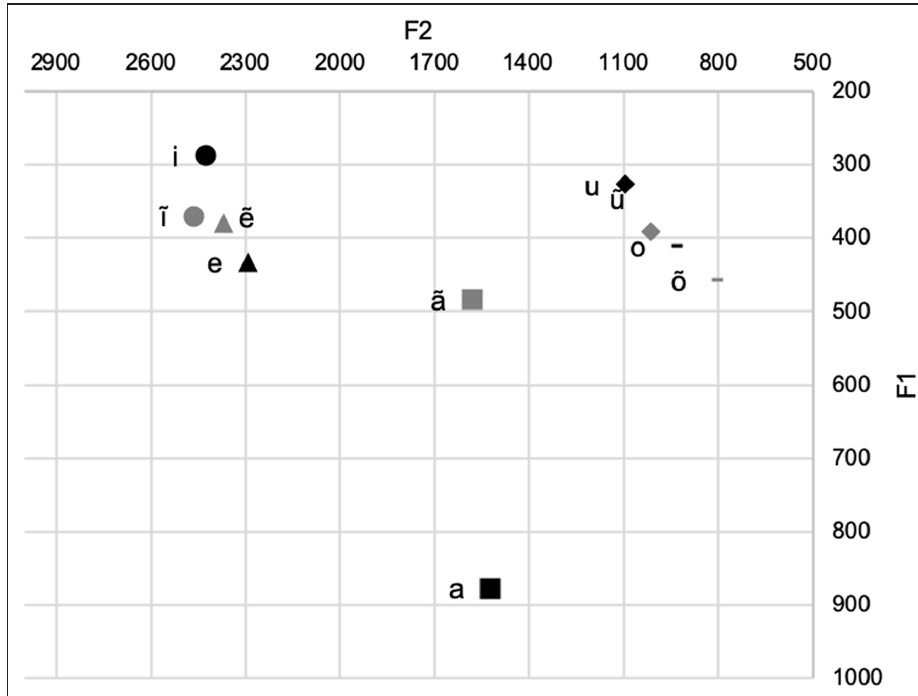
Figure 7: F1 by F2 plot for oral and nasal vowels in the